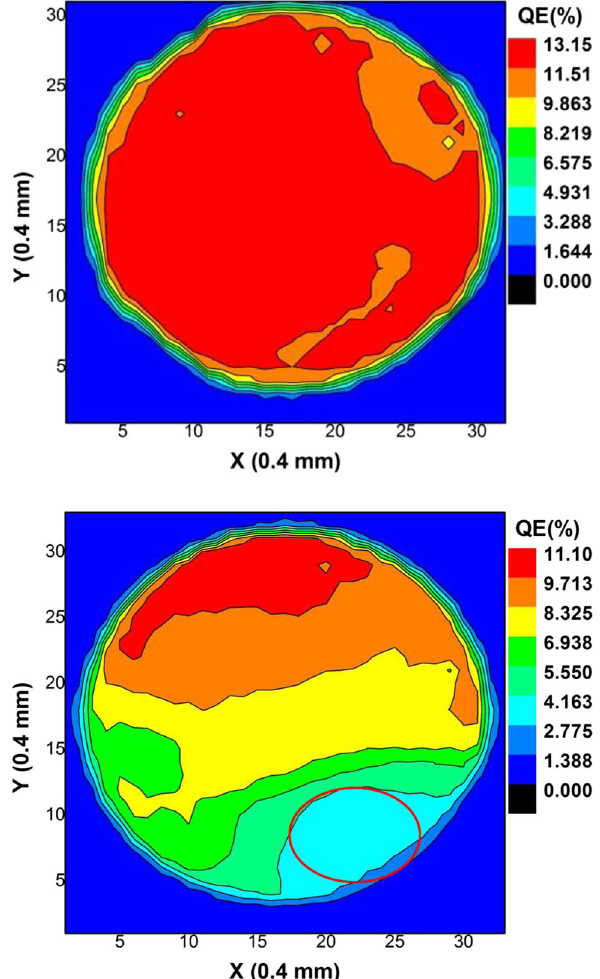
FIG. 7. Typical QE maps of the photocathode obtained by scanning a focused low power green laser beam across the photocathode following activation. These maps show the bulk GaAs (111A) sample. Top: After the third activation following implantation with 100 V hydrogen ions. Bottom: After the third activation following implantation with 10 000 V hydrogen